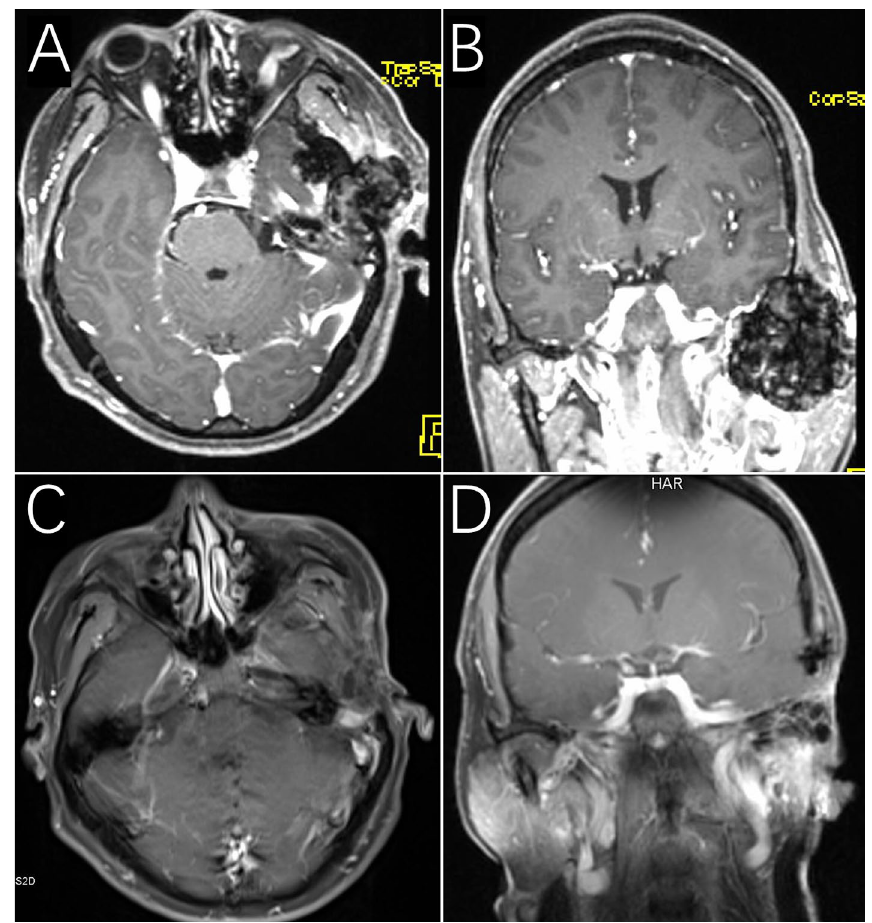
Figure 1. Patient 9: PVNS on MRI showed modest inhomogeneous contrast enhancement, expansive growth and skull base invasion ( A and B ). After 8 months of follow-up, the tumor had not recurred ( C and D ).